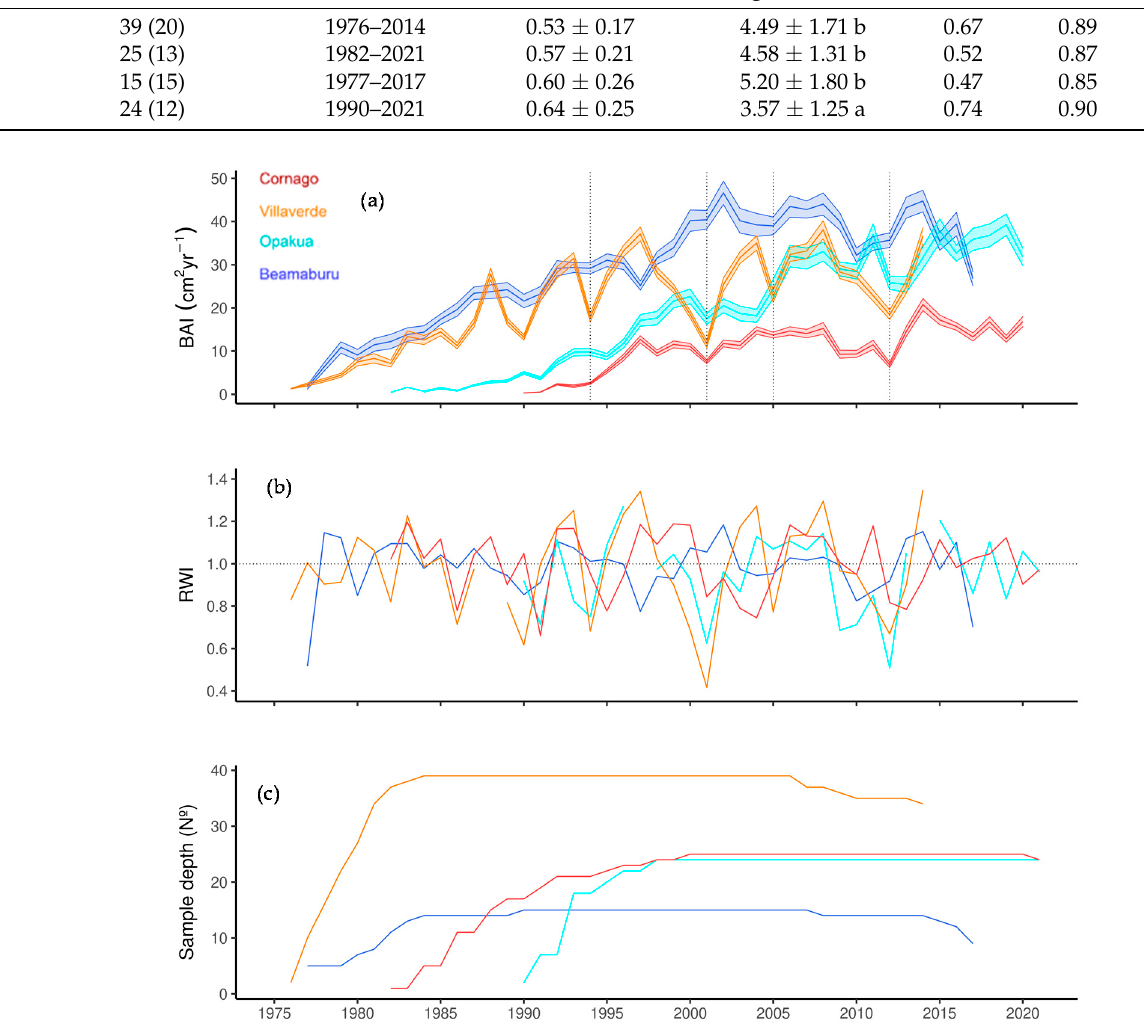
Figure 2. Basal area increment (( a ), BAI) and ring width index (( b ), RWI) for Douglas fir in the four studied sites. For BAI, solid lines represent mean values across individuals and shaded areas are the 95% confidence intervals for the means. The lowest plot ( c ) shows the sample depth (number of cores). In the uppermost plot, the dotted vertical lines show dry years (1994, 2001, 2005 and 2012).